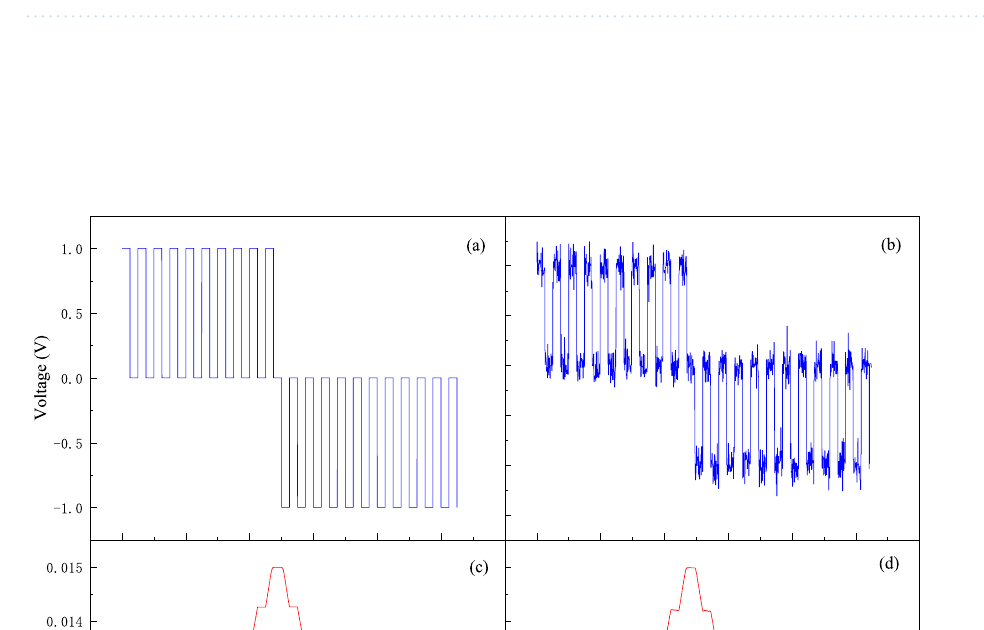
Figure 9. current–voltage (I-V) characteristics of a memristor. ( a ) an ideal HP memristor; ( b ) conductance drift of the memristor.